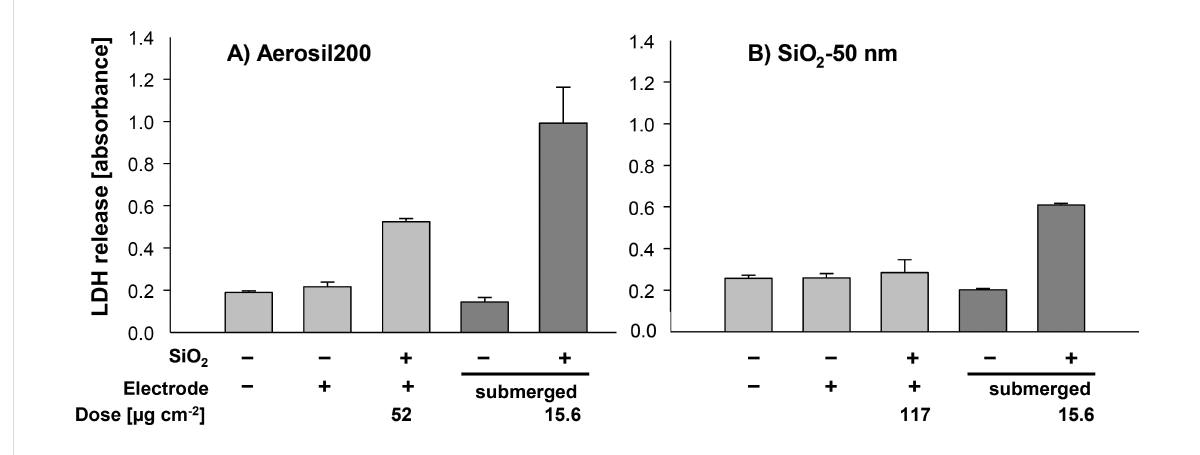
Figure 7: Effects of ALI and submerged exposure to (Aerosil200) and SiO 2 -50 nm agglomerate NPs (B) on the integrity of the membrane of A549 cells determined by LDH release. A549 cells were exposed to filtered air or to aerosols containing Aerosil200 NPs (A) or SiO 2 -50 nm NPs (B) under ALI conditions with application of an electrode (+). Controls were exposed to filtered air with or without electrode ( − ). The mass doses after ALI expo- sure were 52 µg·cm − 2 for Aerosil200 NPs after 5 h and 117 µg·cm − 2 for SiO 2 -50 nm NPs after 7 h. Subsequently, cells were post-incubated in medium without FCS and supernatants were processed 24 h after the onset of exposure. For comparison, cells were treated for 24 h with an esti- mated maximal dose of 15.6 µg·cm − 2 (50 µg·mL − 1 ) applied as suspension in medium without FCS or with medium alone. Results are means ± s.e.m. of 4 to 6 samples originating from three (A) and two independent experiments